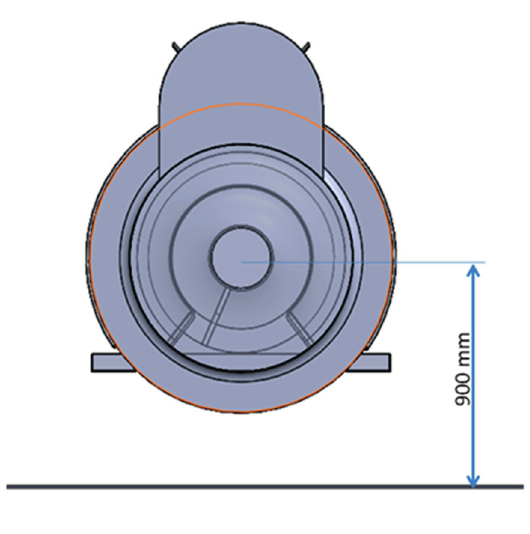
Figure 6. Location of rotors of the fans of the sprayer in the CFD simulation